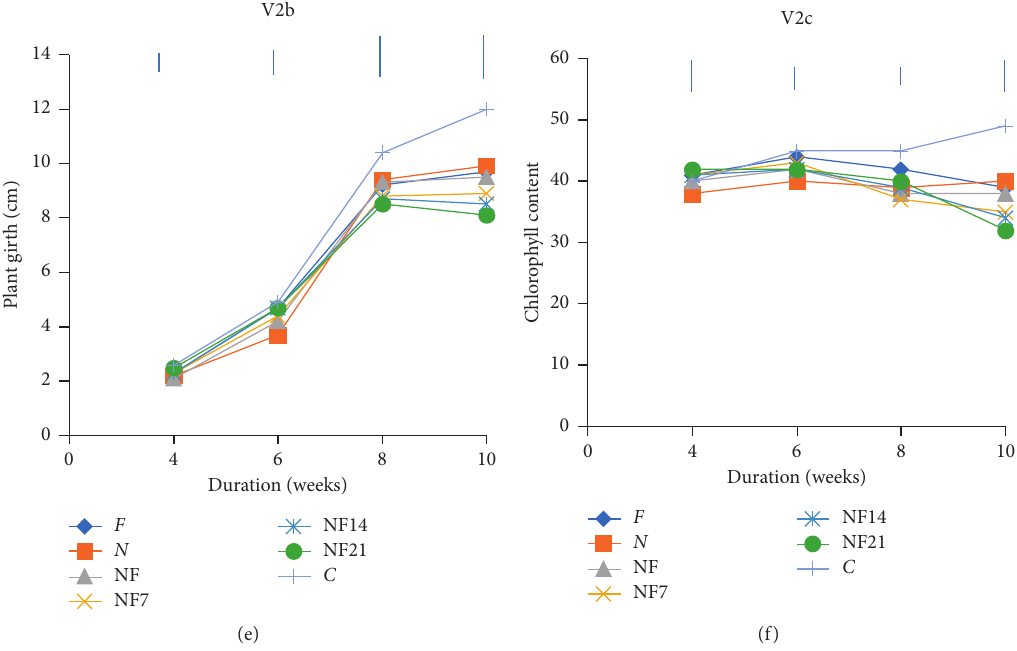
Figure 1: Plant height, girth, and chlorophyll contents of Essoumtem (V1a, V1b, and V1c) and Clemson spineless (V2a, V2b, and V2c) okra plants inoculated individually and simultaneously with Meloidogyne incognita and Fusarium oxysporum f sp. vasinfectum in pot experiment. F � fungus alone; N � nematode alone; NF � nematode and fungus, simultaneously; NF7 � fungus 7 days after nematode inoculation; NF14 � fungus 14 days after nematode inoculation; NF21 � fungus 21 days after nematode inoculation; and C � control